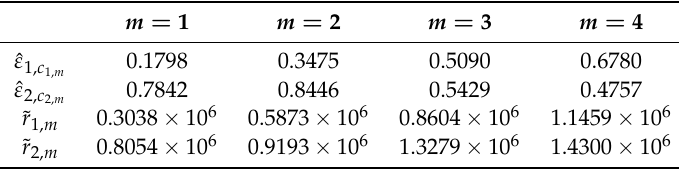
Table 3. The classified CRT remainders and normalized frequencies in Step